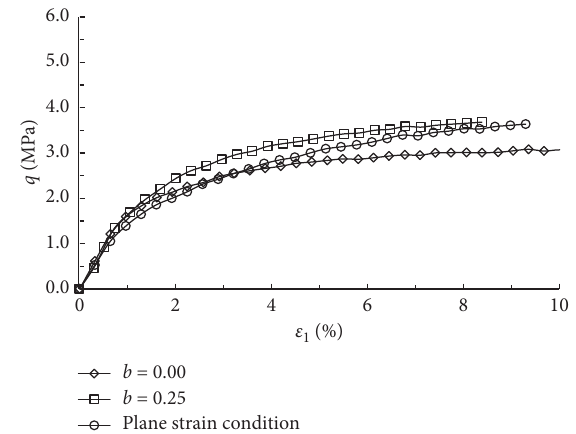
3 and constant b test and